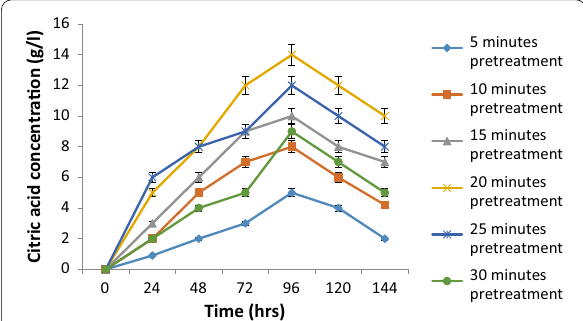
Fig. 2 Effect of wild cocoyam pretreatment on citric acid production